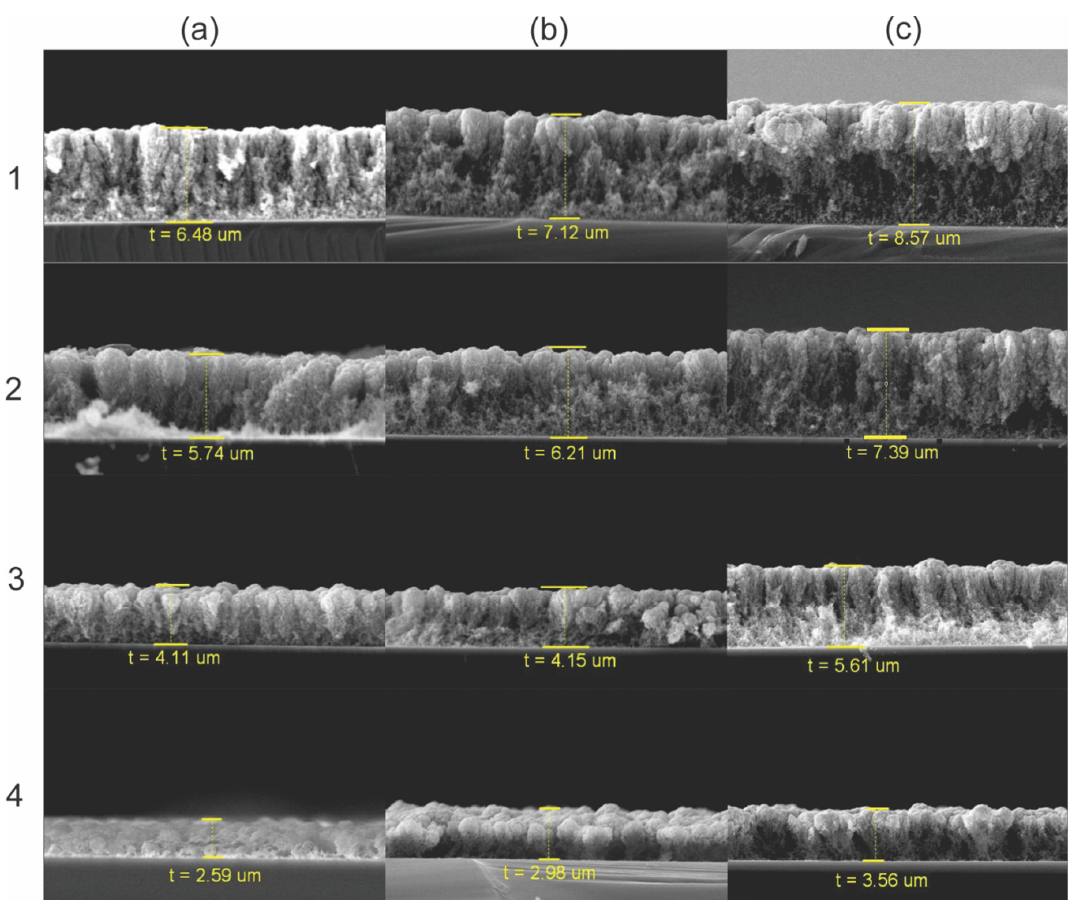
Figure 2. Scanning electron microscopy (SEM) images showing the thickness of the films; column ( a ): s5m, column ( b ): s10m, column ( c ): s15m; row 1: As-synthesized; annealed at: row 2: 100 °C, row 3: 300 °C, and row 4: 500 °C.